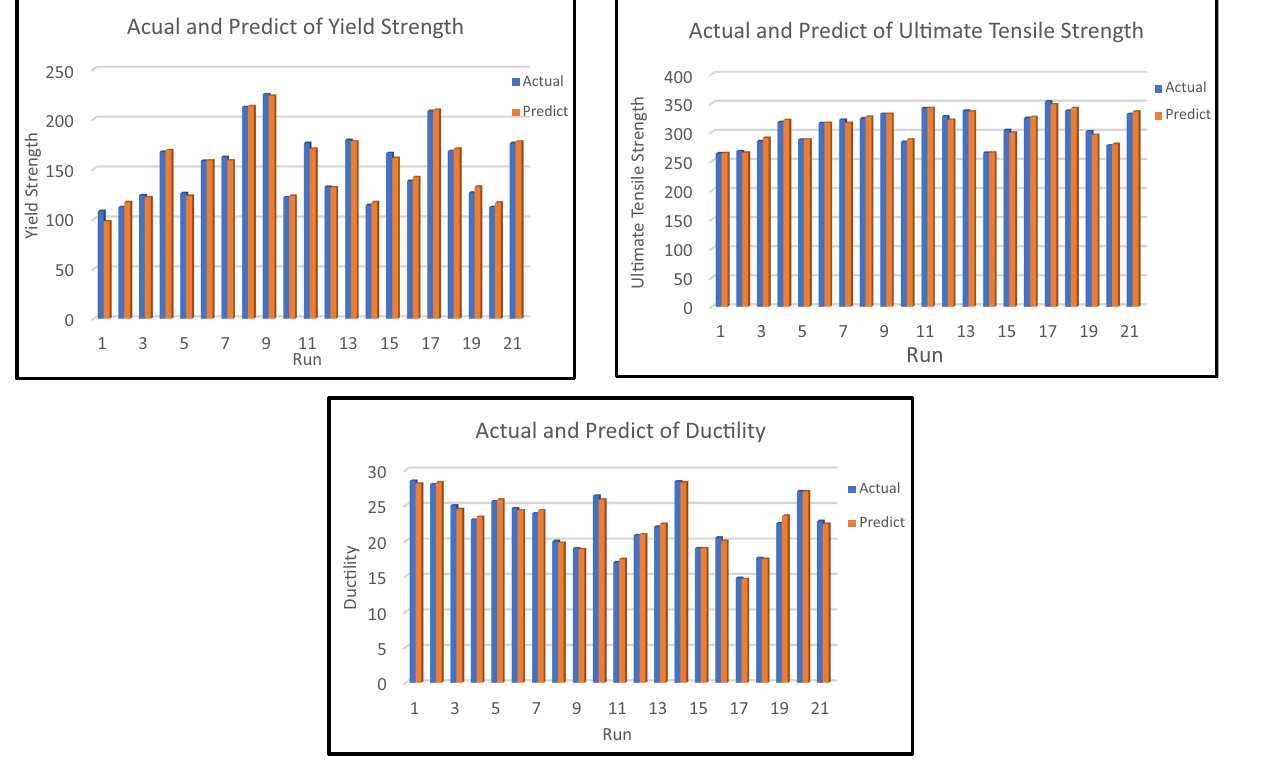
Figure 10: Predicted and actual values of σ y , σ u , and D u for